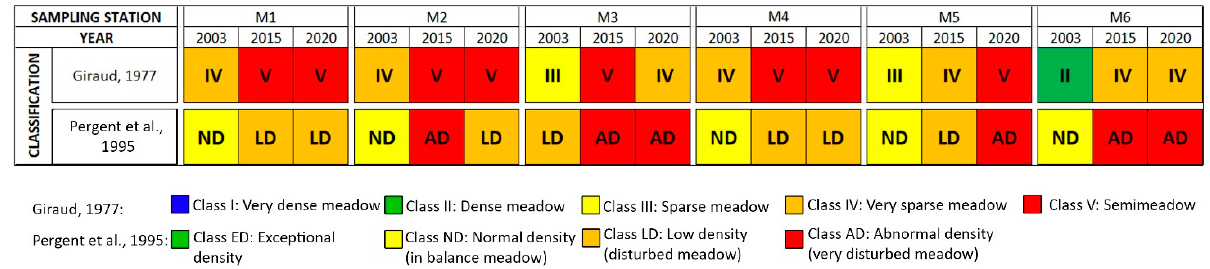
Figure 2. Variations in absolute and relative rhizome density (rhizomes m − 2 ), leaf area index (LAI, m 2 m − 2 ), and rhizome age (lepidochronological years) of Posidonia oceanica at the Tremiti Archipelago in 2003, 2015, and 2020. Data represented as mean ± standard deviation. Information about each sampling station is reported in Table 1 and the text.